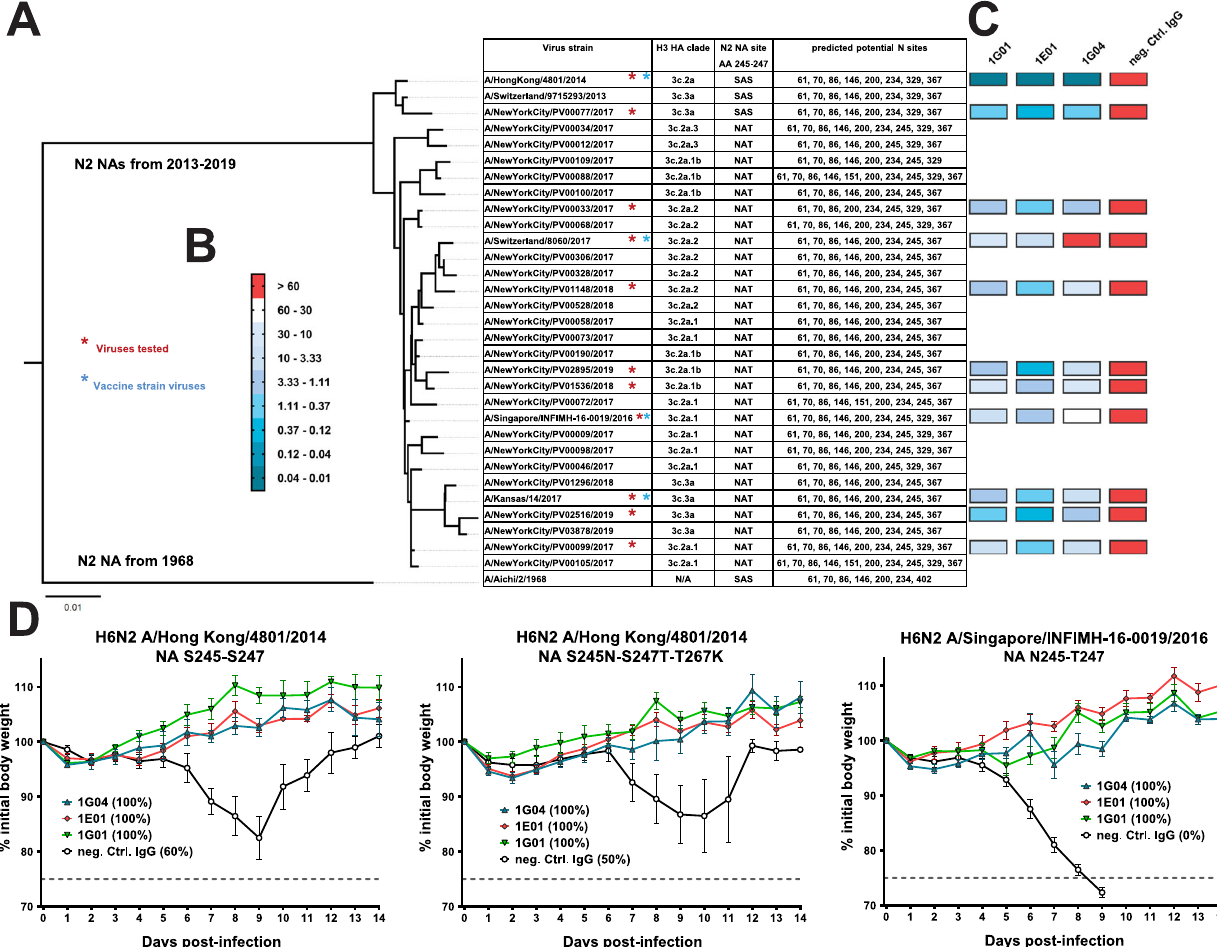
Fig. 1 | Phylogenetic tree of N2 NA of H3N2 viruses and functional character- ization of NA-speci fi c antibodies. A Phylogenetic tree of N2 NAs. The scale bar represents a 1% change in nucleotides. The tree was built using nucleotide sequences in ClustalOmega and visualized in FigTree. Vaccine virus strains and other strains tested in this study are indicated. The H3N2 clade (based on HA), the amino acid residues at position 245 – 247, and all predicted potential glycosylation sites are shown. B Scale bar for the IC 50 in μ g/ml of viruses tested as shown in the heatmap. C HeatmapofIC 50 ofthreeNAantibodiesandirrelevantIgGcontrolmAb. IC 50 values shown were measured in ELLAs except for viruses A/New York City/ PV00033/2017 and A/New York City/PV00077/2017, were the inhibitory